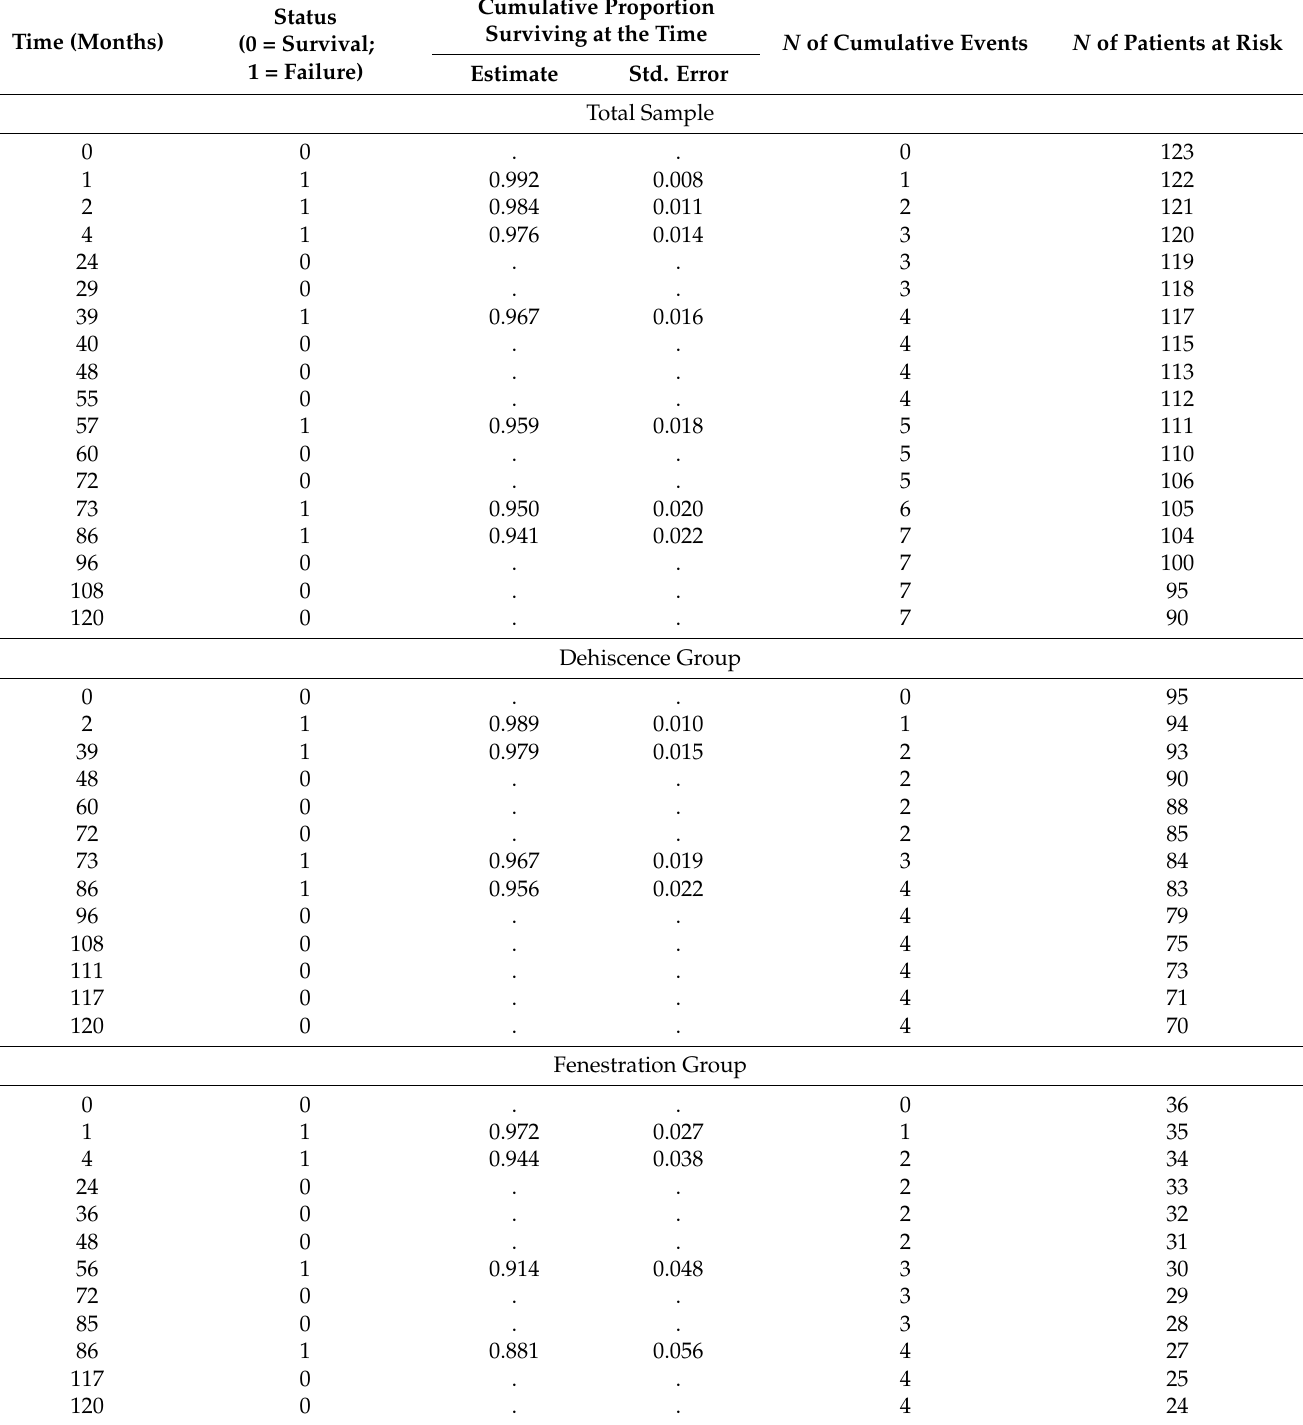
Table 3. Cumulative implant survival rate using the patient as the unit of analysis: total sample and per group estimations (Kaplan–Meier product limit